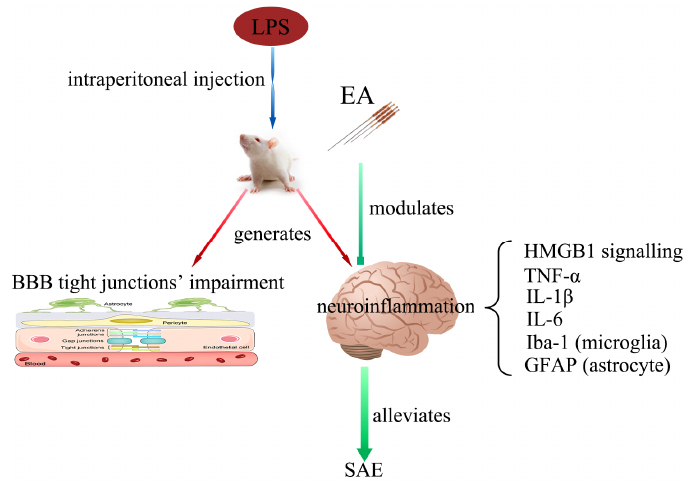
Figure 9. Working model: intraperitoneal injection of LPS to induce SAE impairs BBB’s tight junctions and evokes neuroinflammation in the hippocampus. The expression levels of HMGB1 signaling are enhanced, microglia and astrocytes are activated, and the content of pro-inflammatory factors is elevated. EA can modulate the HMGB1 signaling and relieve the intensity of neuroinflammation in the hippocampus. However, EA does not affect the tight junctions’ impairment of BBB. Abbreviations: BBB, blood–brain barrier; EA, electroacupuncture; GFAP, glial fibrillary acidic protein; HMGB1, high mobility group box 1 protein; Iba-1, ionized calcium-binding adapter molecule 1; IL-1 β , interleukin-1 β ; IL-6, interleukin-6; LPS, lipopolysaccharide; TNF- α , tumor necrosis factor α ; SAE: sepsis-associated encephalopathy.